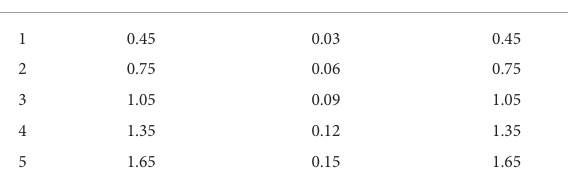
TABLE 5 Factor level table.